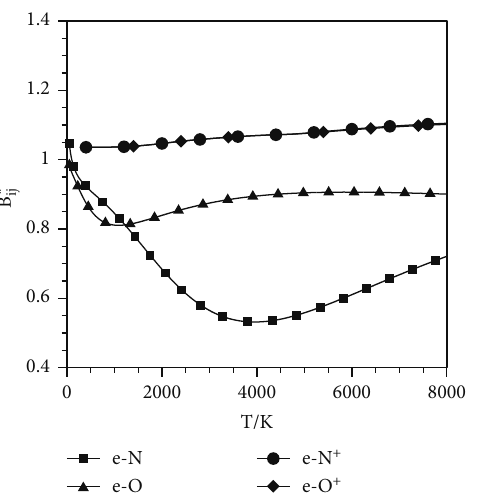
Figure 10: Relative deviation of translational thermal conductivity between equation (5) at three assumptions of B ∗ ij and the CE method at 0.001atm.